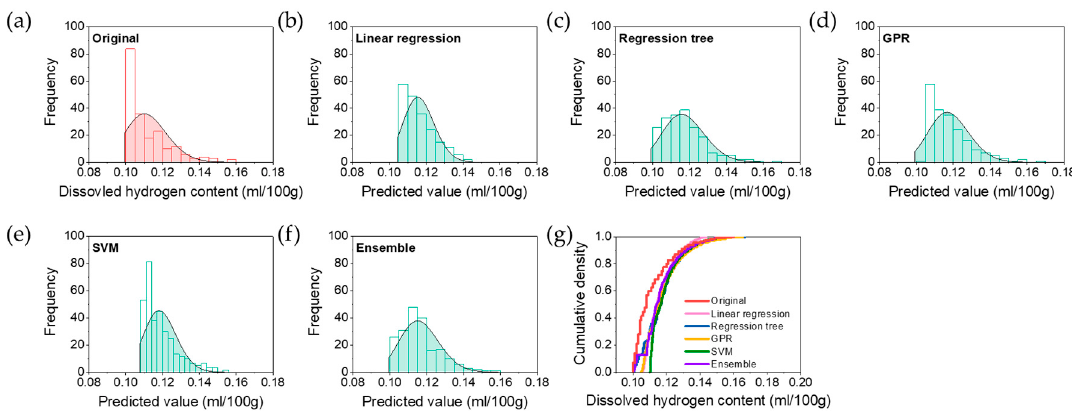
Figure 7. Data distribution of dissolved hydrogen content in liquid aluminum temperature from ( a )